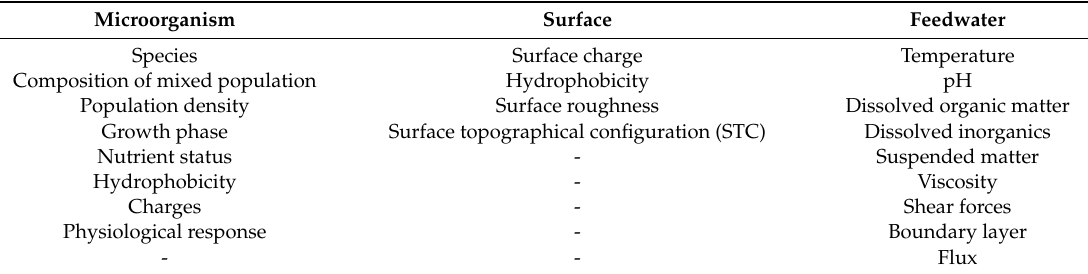
Table 3. Factors a ff ecting microbial adhesion to bioreactor surfaces